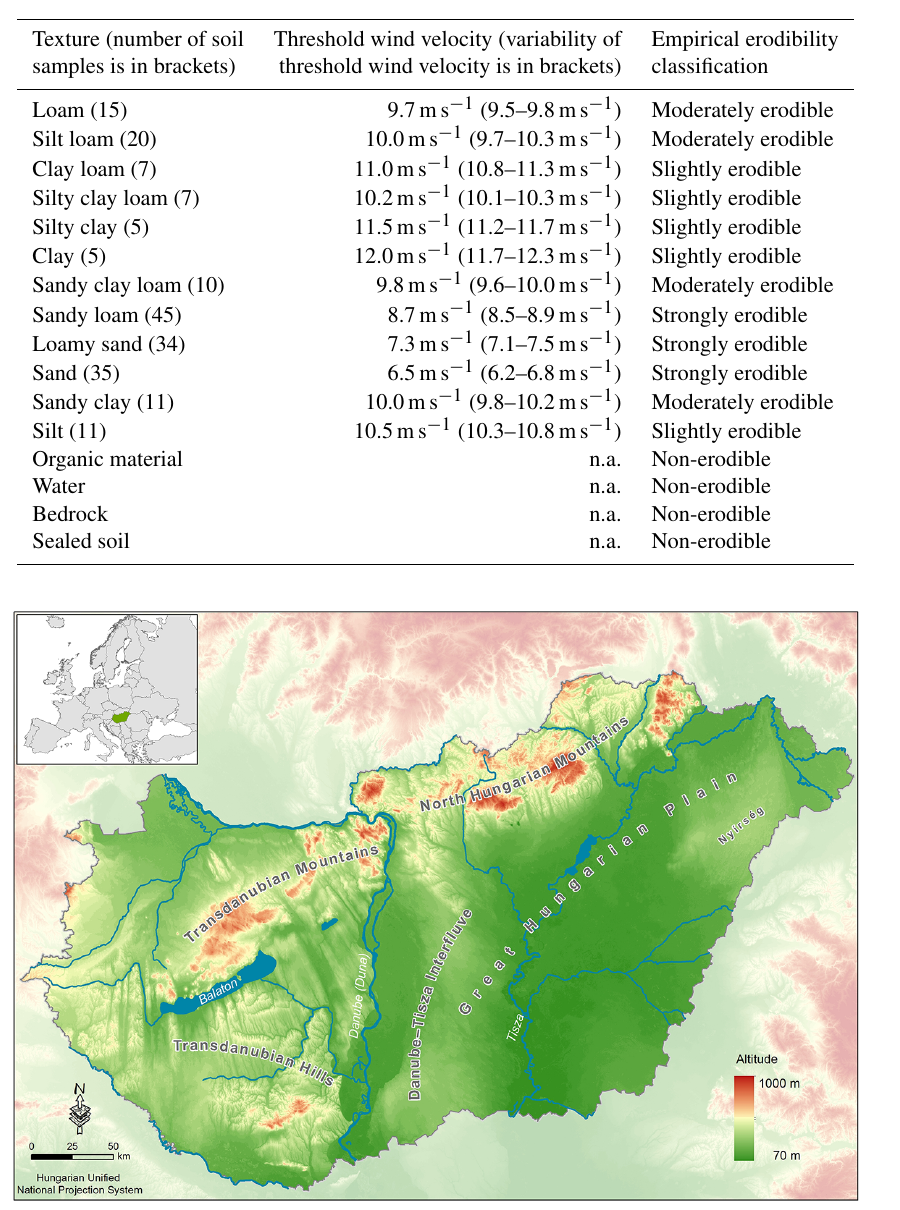
Figure 2. Hungary’s general geographical conditions.